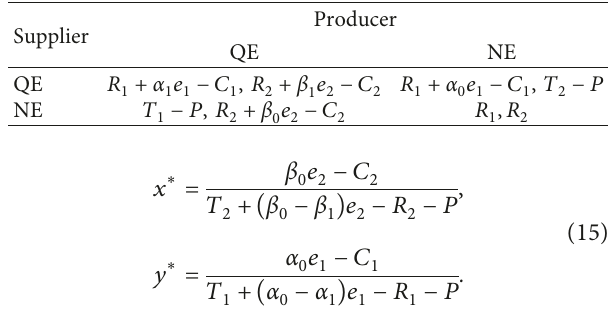
Table 7: Payoff matrix under the punishment